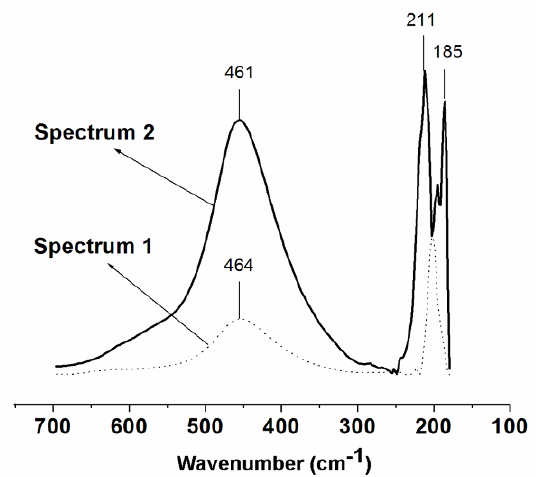
Figure 4. Far-IR spectra of the catalyst (spectrum 2) and silica (spectrum 1) samples.